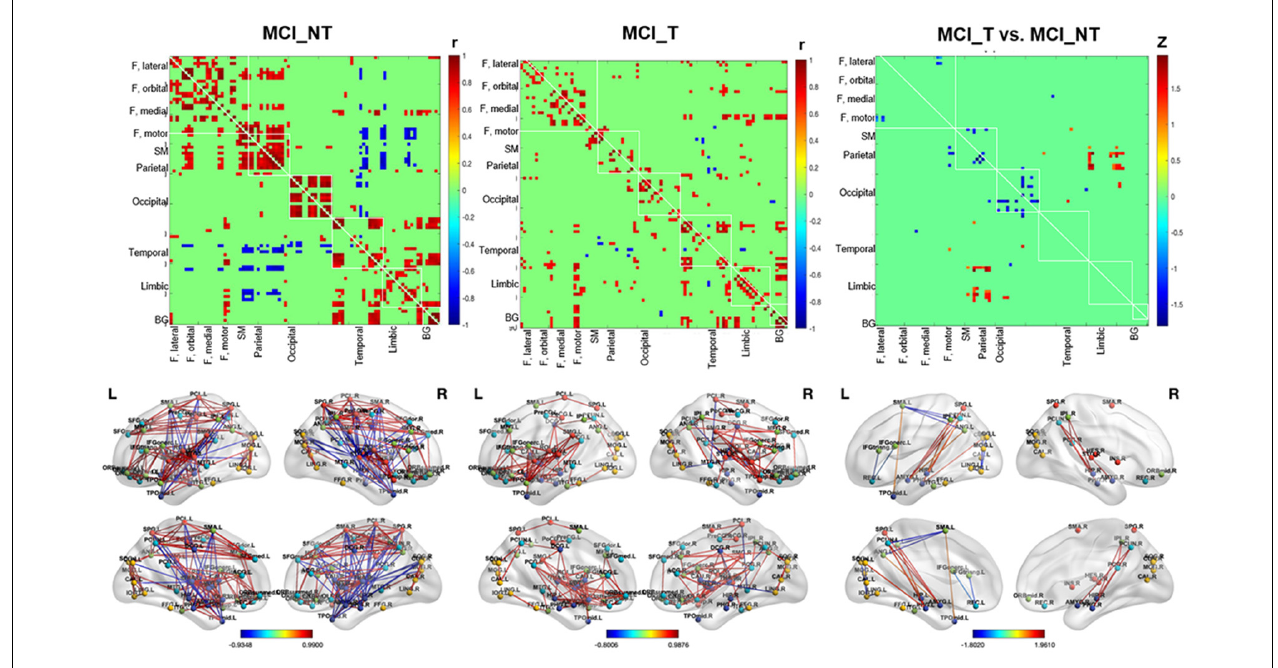
FIGURE 4 | Whole-brain glucose metabolic connectivity. (First left and middle column) Figures show the whole-brain metabolic connectivity matrix among 90 by 90 regions of MCI_NT and MCI_T based on correlation, respectively, with color gradient representing the strength of correlation between two nodes, at p -value < 0.01. (Right column) The figure shows differences in metabolic connectivity in MCI_T compared to MCI_NT, at p -value < 0.01. Values were based on the z-transformed correlations within (diagonal) and between (off-diagonal) ROIs. The color bar represents Fisher’s Z. The difference in real connectivity matrix was compared with the null distribution, generated by permutation testing. The second row shows connections between two nodes projected on a 3D template.